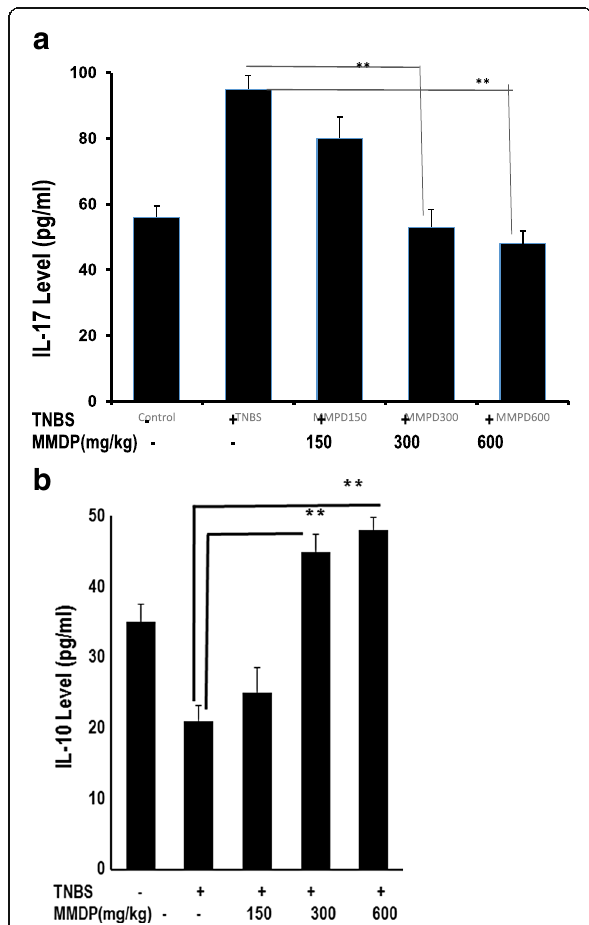
Fig. 6 The increase in TNBS-induced IL-17 and reduction IL-10 levels in colon homogenates from the acute colitis model. a . ELISAs were performed for IL-17, MMDP extract suppressed TNBS-induced IL-17. b . ELISAs were performed for IL-10, but MMDP extract increased IL- 10 production, as assessed by ELISA from supernatants of MLNs. Re- sults shown are mean + SD, with n = 6 replicates in each group. ∗ p < 0.05, p < 0.001 versus control TNBS-induced colitis